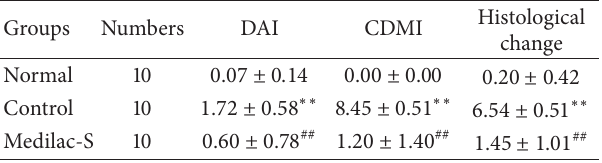
Table 1: DAI, CDMI, and histological change in groups. Groups